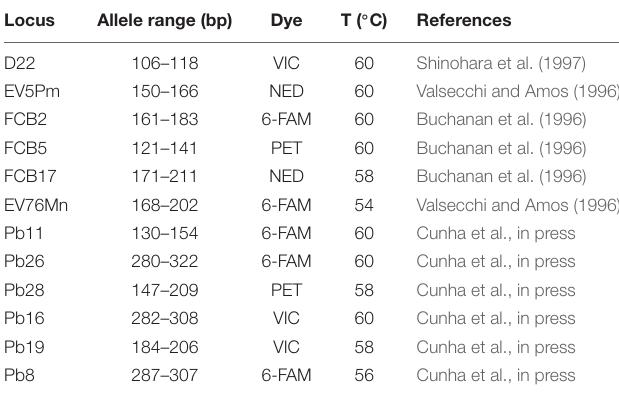
TABLE 1 | Microsatellite loci used to access genetic diversity of franciscana ( Pontoporia blainvillei ). Locus name (Locus), allele range of amplified fragments size (base pairs, bp), fluorescent primer labeling (dye), annealing temperature (T), and original loci development (reference). Locus Allele range